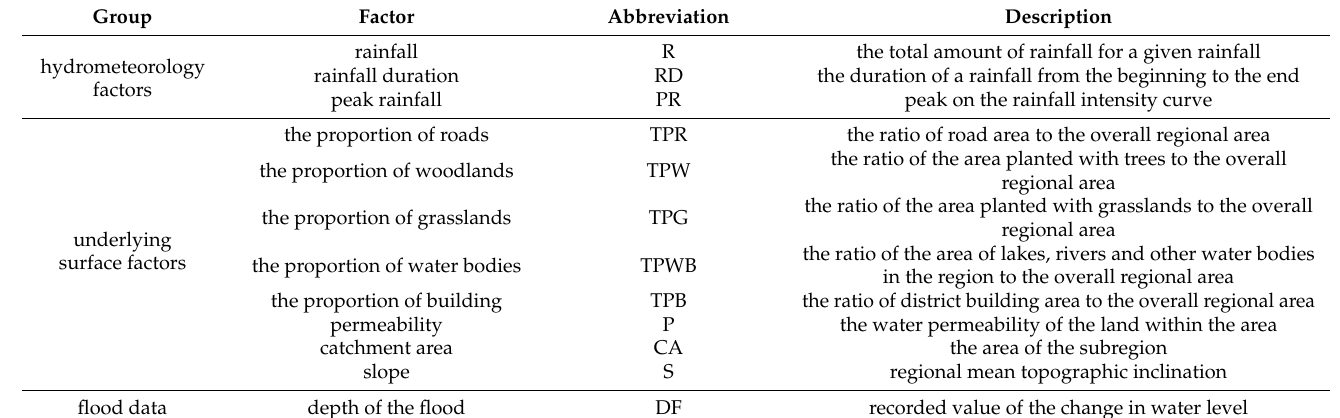
Table 1. Descriptions of 11 impact factors and flood data in the